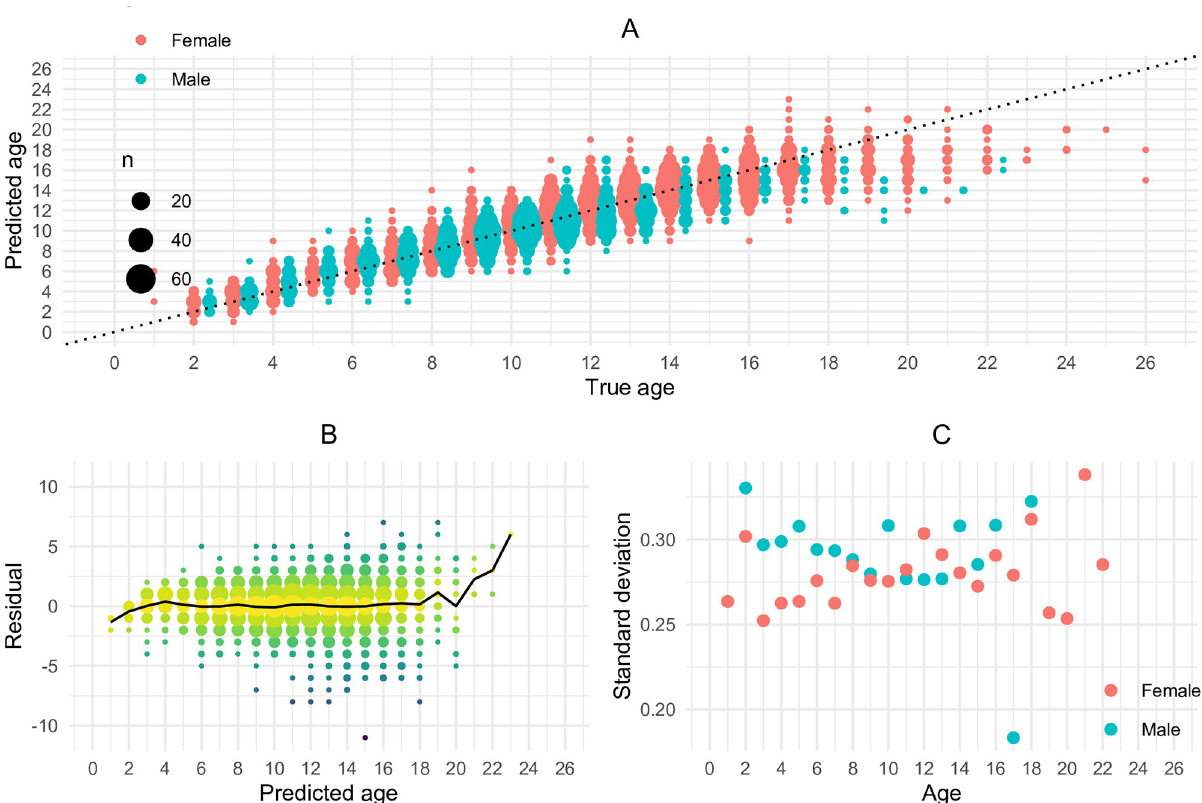
Fig 9. Scatter plot of predictions and residuals. A: Scatter plot of the predicted age against the ground truth (read age). B: Residuals plotted against predicted age (solid line shows average residuals). C: Empirical standard deviation for the residuals plotted against read age. The standard deviations are computed for each age, using the residuals corresponding to that age as the